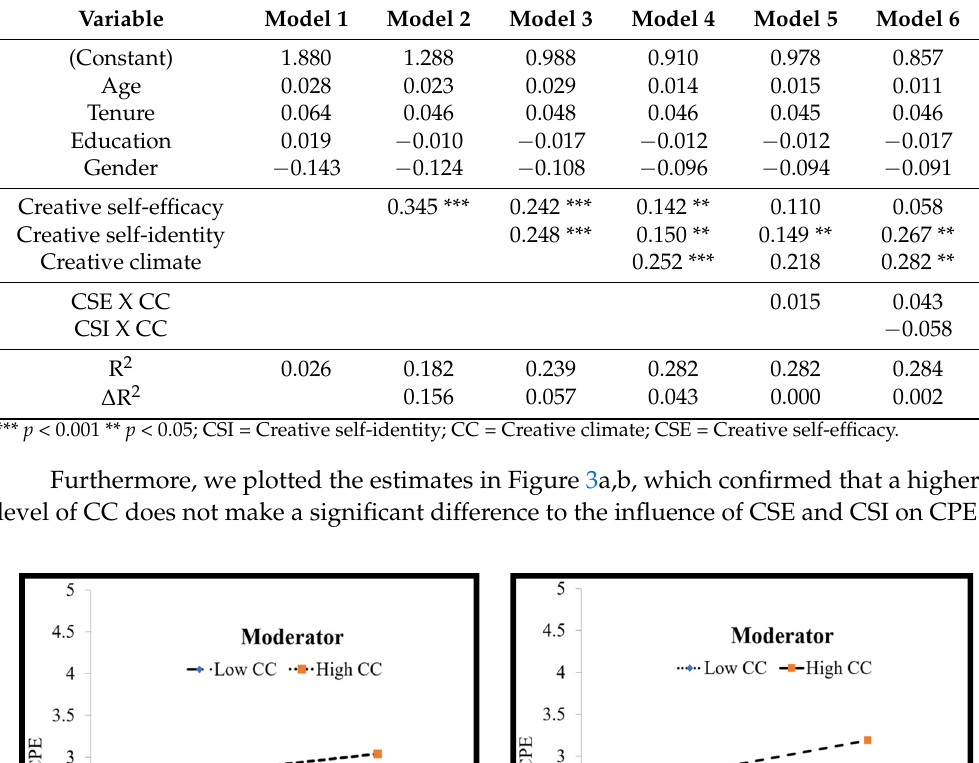
Table 5. Moderation effect.